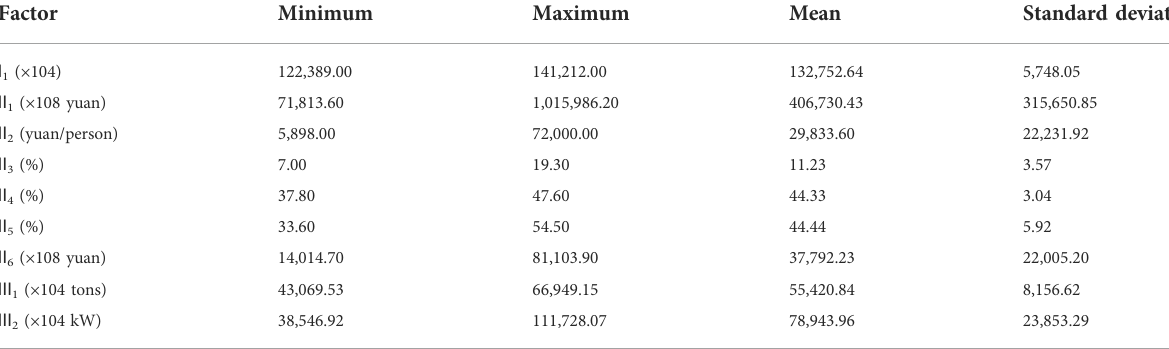
TABLE 2 Descriptive statistical characteristics of social, economic and agricultural factors from 1996 to 2019. Factor